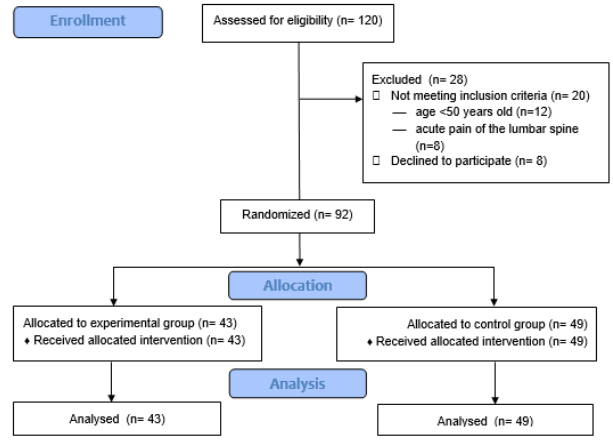
Figure 1. Flow chart of study enrollment, allocation and analysis.